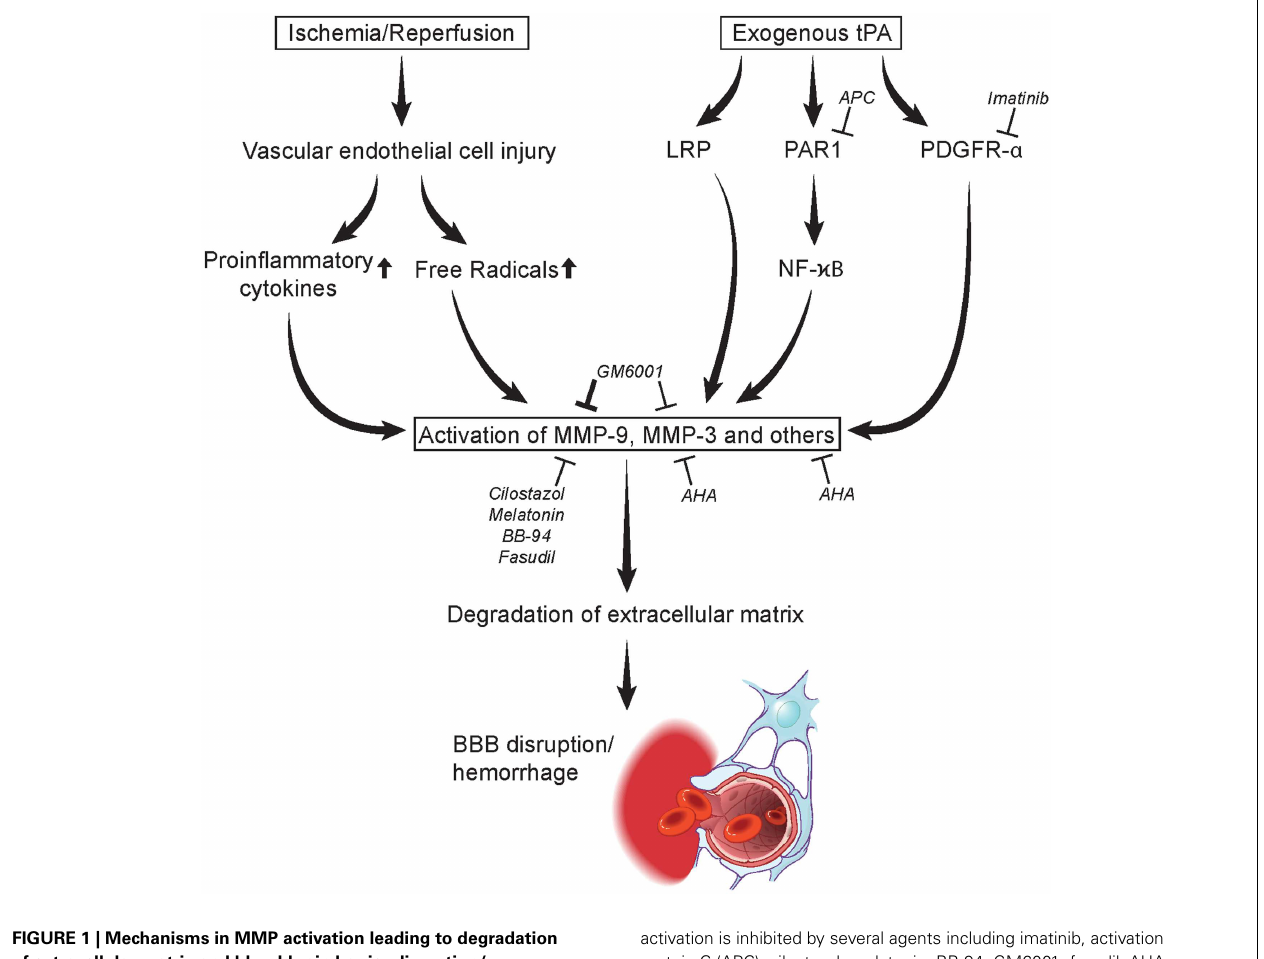
FIGURE 1 | Mechanisms in MMP activation leading to degradation of extracellular matrix and blood-brain barrier disruption/ hemorrhage. Acute stroke may lead to vascular endothelial cell injury causing the release of proinflammatory cytokines and free radicals at the neurovascular unit activating MMPs. tPA administration may likewise induce MMPs through the LRP, PAR1, and PDGRF- α pathways. MMP